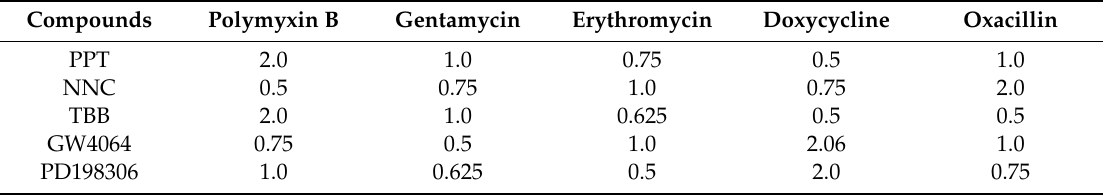
from di ff erent